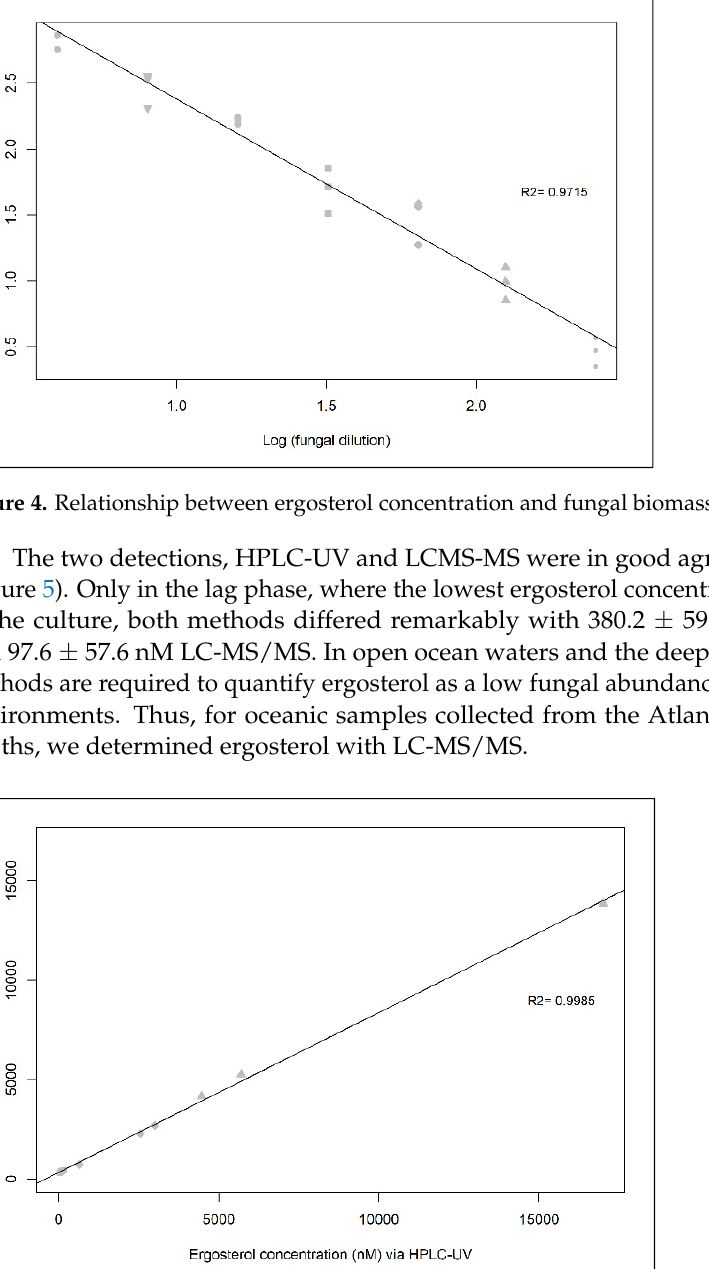
Figure 3. LC ‐ UV ‐ chromatogram of ergosterol obtained with chloroform–methanol extraction from the marine fungal isolate Rhodotorula sphaerocarpa . Five fungal dilutions in artificial seawater are shown (4×, 8×, 16×, 32×, and 64×), and the x ‐ axis shows minutes of the run.